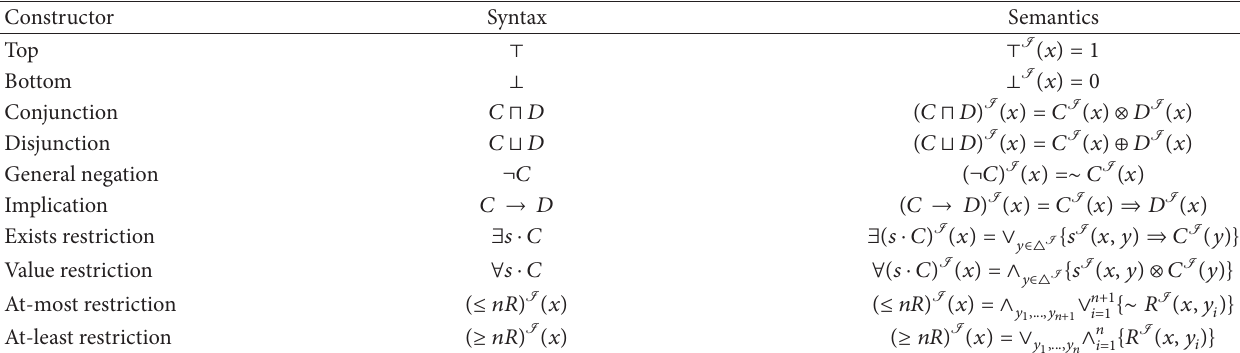
Table 1: Semantics of 𝐿 - SHIN concepts and 𝐿 - SHIN